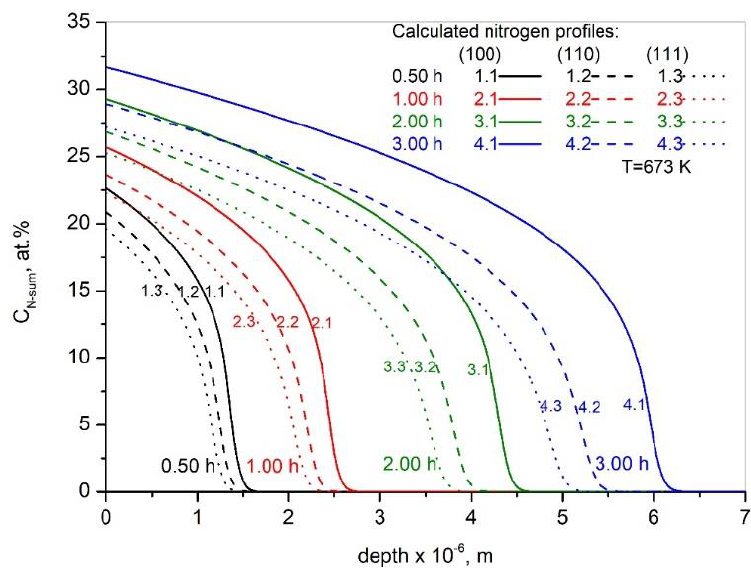
Figure 5. Nitrogen depth profiles evolution in the (100), (110) and (111) oriented single crystals of ASS. Depth profiles after nitriding time 0.50 h, 1.00 h, 2.00 h and 3.00 h at 673 K temperature are presented.